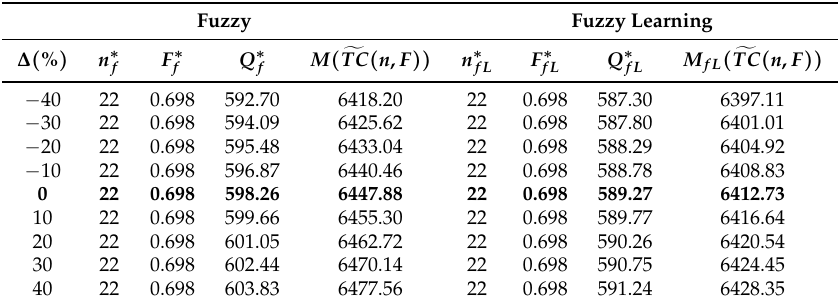
Table 6. Percentage of ∆ changes on the fuzzy and fuzzy-learning models.